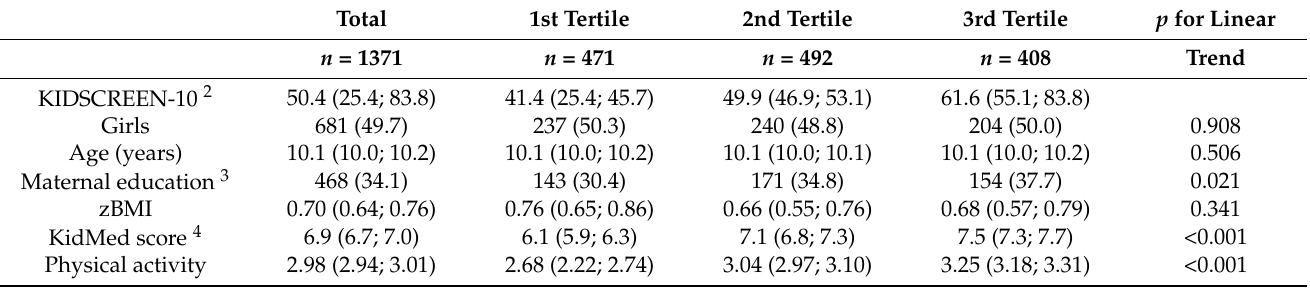
Table 1. Baseline characteristics of the study population according to health-related quality of life 1 .